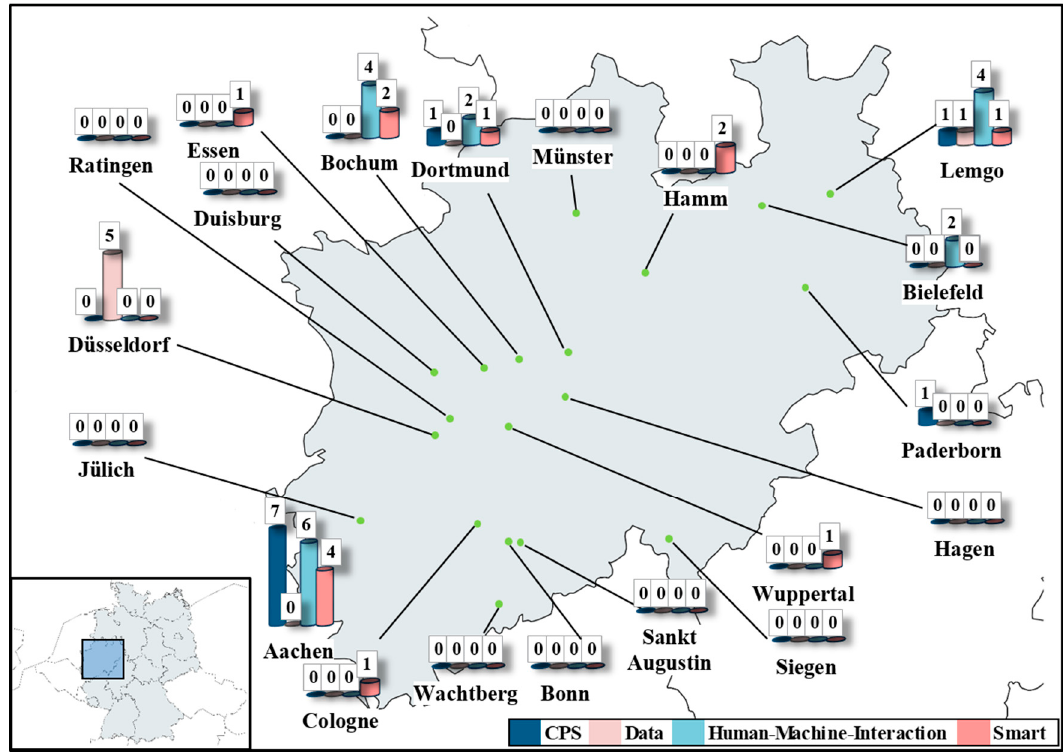
Figure 10. Papers identified in the correlated regional analysis. Sources of the shapefile [38-40].